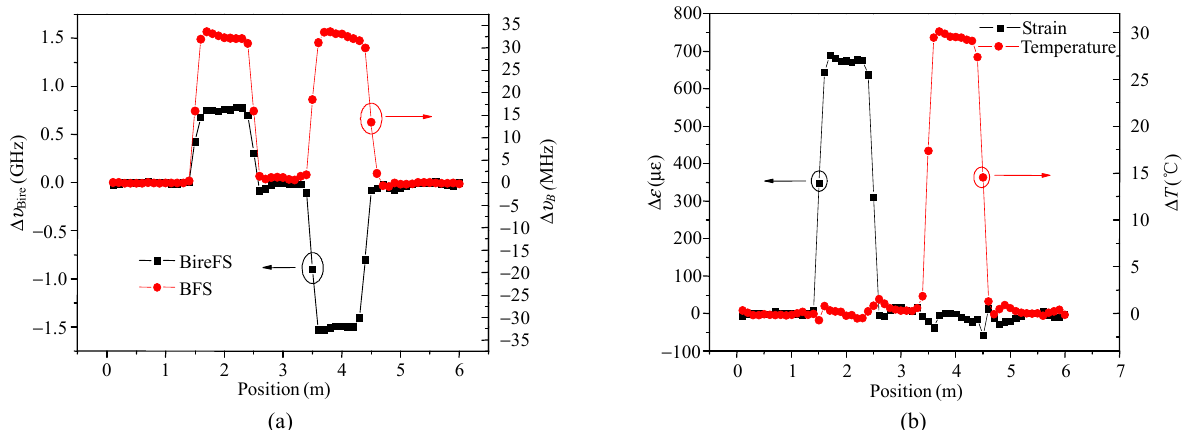
Fig. 14 Discrimination of temperature and strain: (a) measured birefringence-induced frequency shift and Brillouin frequency shift and (b) demodulated temperature and strain